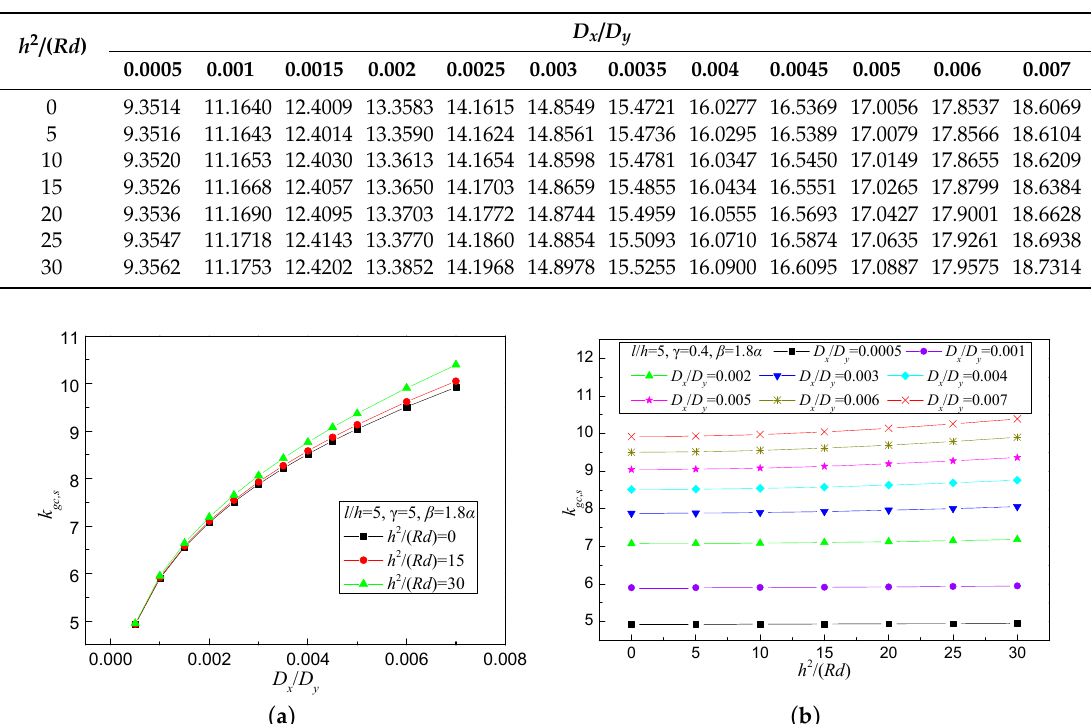
Figure 4. The effect of D x /D y and h 2 /( Rd ) on the global shear buckling coefficient k g , s for the four-edge Figure 4. The e ff ect of D